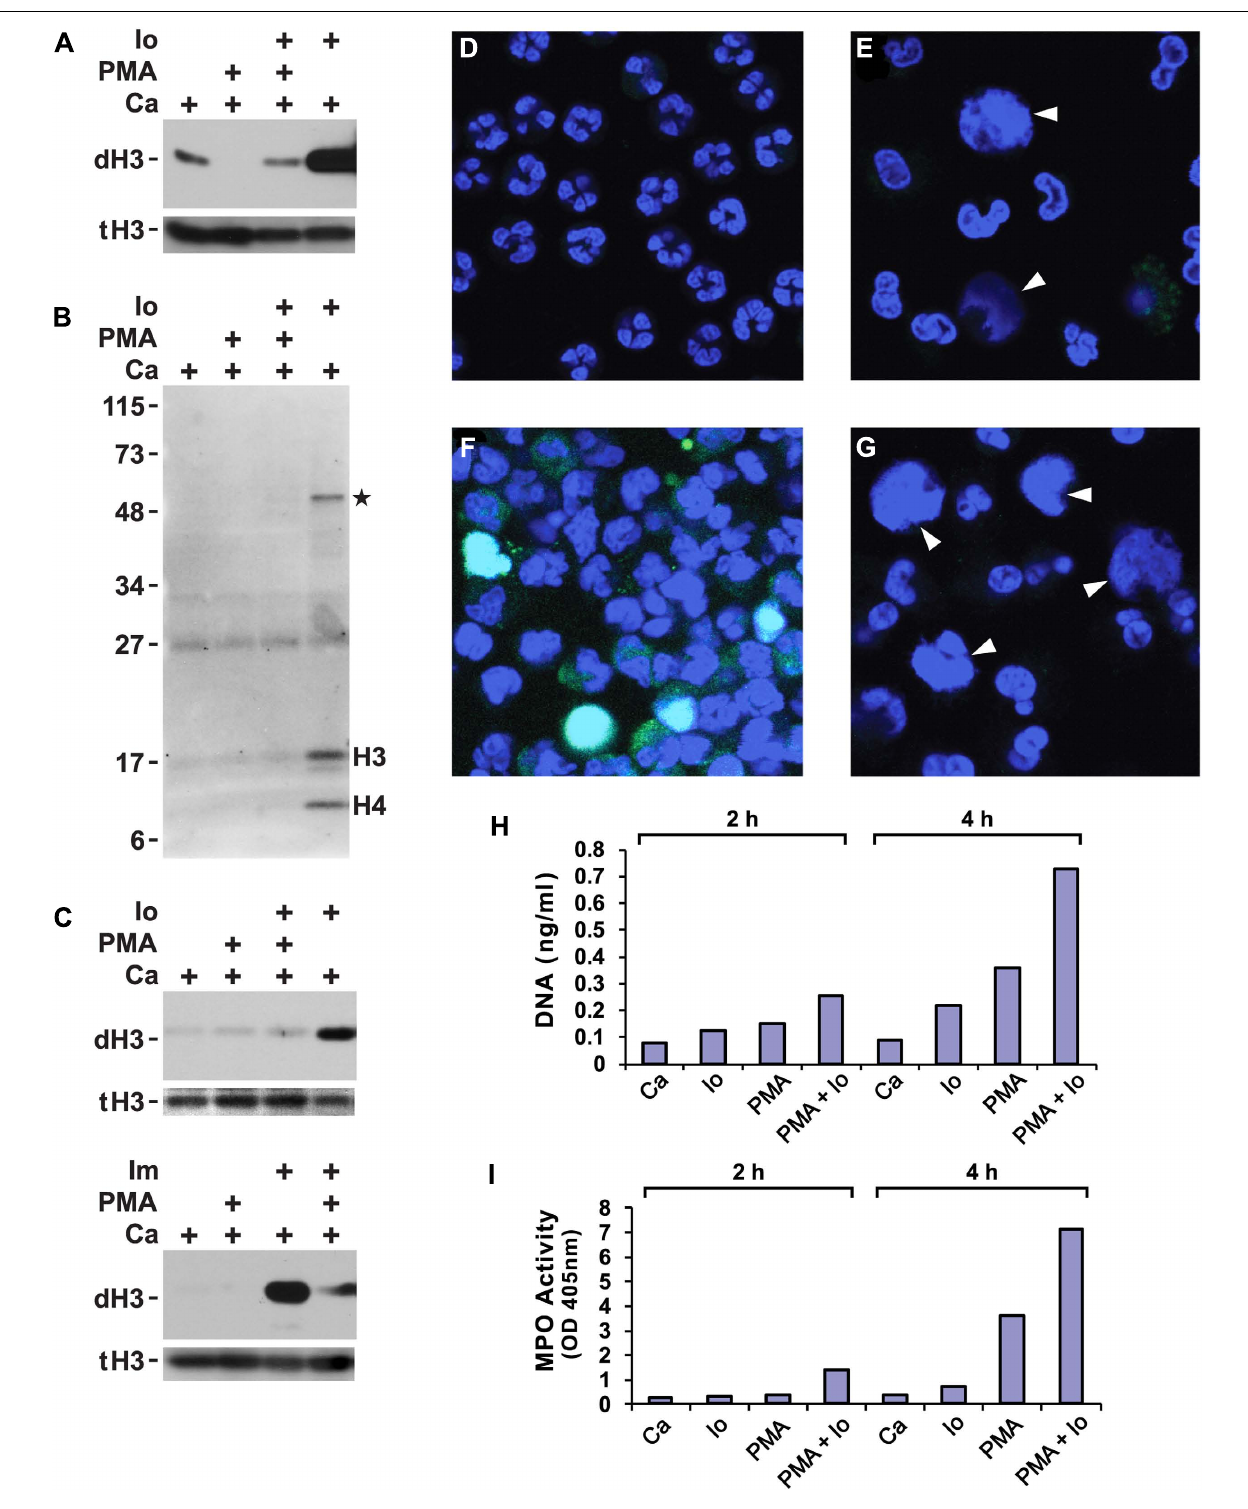
FIGURE 1 | Phorbol myristate acetate (PMA) suppresses histone deimination, whereas ionophore or ionomycin stimulate deimination. Purified neutrophils were incubated in buffers containing calcium (Ca),